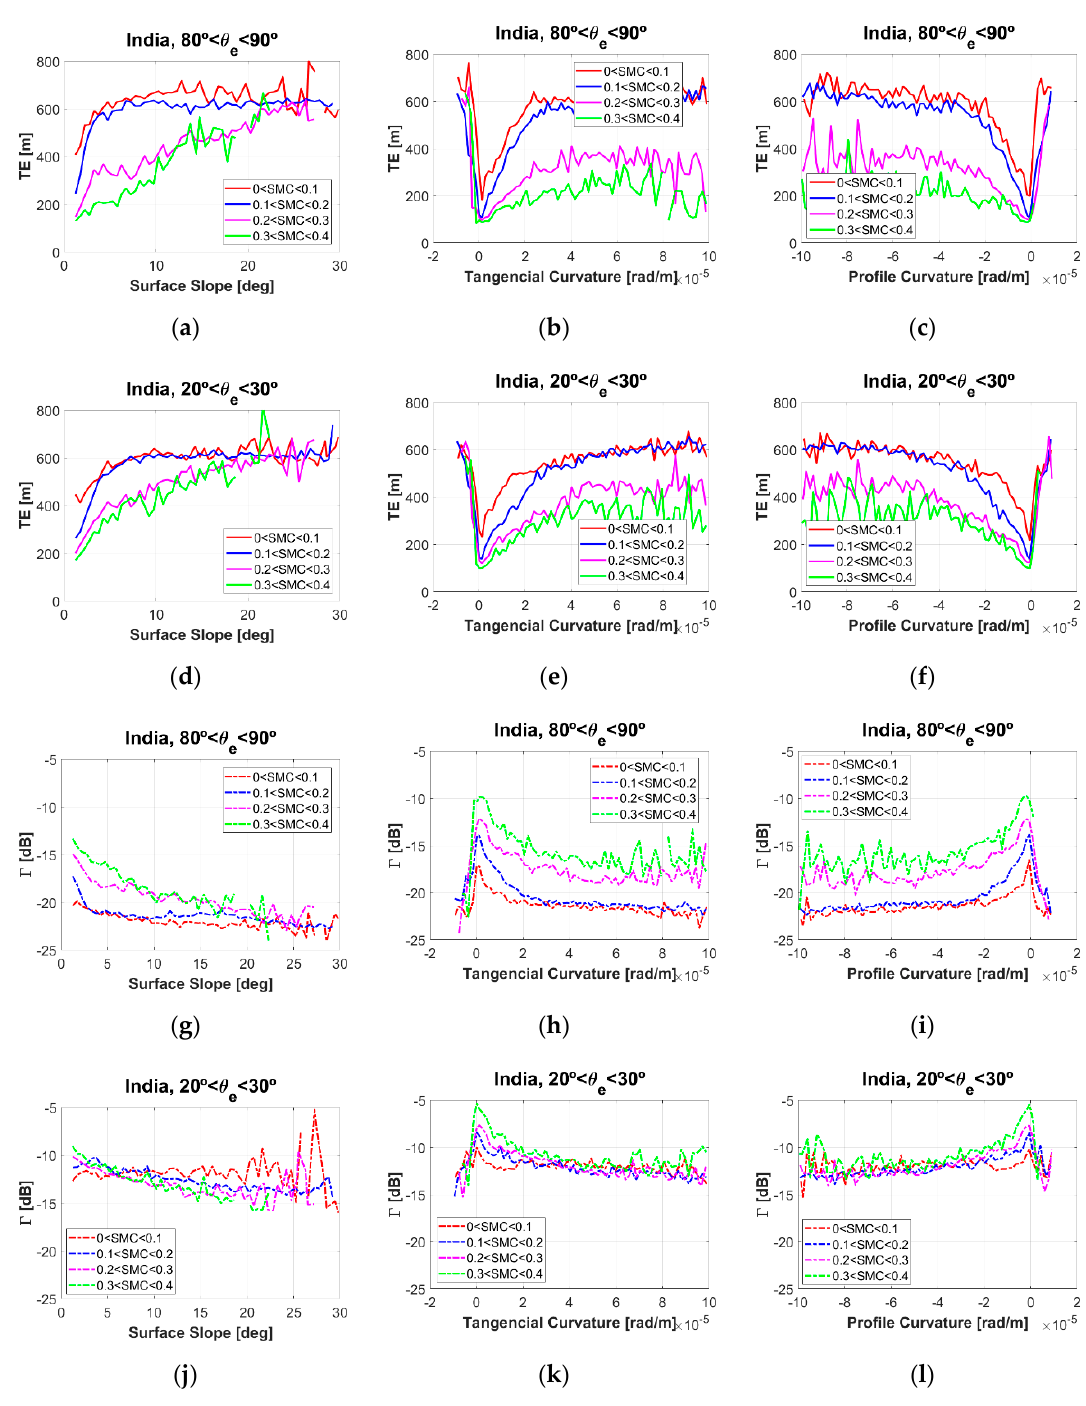
Figure 6. Parametric evaluation as a function of SMAP-derived SMC: ( a , d , g , j ) β , ( b , e , h , k ) TC , and ( c , f , i , l ) PC. Analysis of CyGNSS-derived TE at θ e ~ [80, 90] ◦ ( a – c ) and θ e ~ [20, 30] ◦ ( d – f ). Analysis of CyGNSS-derived Γ at θ e ~ [80, 90] ◦ ( g – i ) and θ e ~ [20, 30] ◦ ( j – l